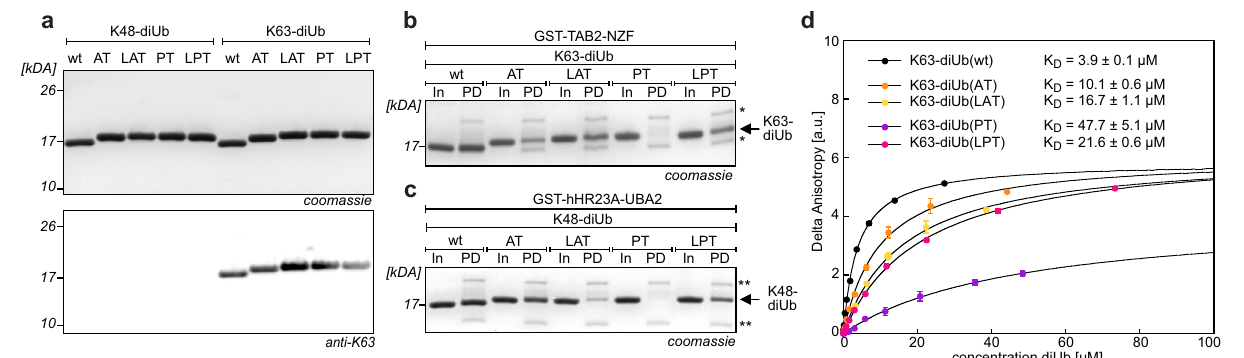
Fig. 2 Functional characterization of sortase-generated diUb building blocks used for Ubl-tools. a SDS-PAGE of K48- and K63-linked diUbs displaying different sortase motifs at their linkage sites (top: Coomassie-stained SDS-PAGE gels, bottom: western blot (WB) using an anti-K63-linkage-speci fi c antibody). b SDS-PAGE analysis of pull-down (PD) experiments using differently linked K63-diUbs and GST-fused TAB2-NZF. Single asterisk (*) marks impurities present in GST-TAB2-NZF. c SDS-PAGE analysis of PD experiments using differently linked K48-diUbs and GST-fused hHR23A-UBA2 (bottom). Double asterisks (**) marks impurities present in GST- hHR23A-UBA2. In: input of differently linked K48- or K63-diUbs, PD: pull-down. Full gels can be found in Supplementary Fig. 4. d Determination of binding constants of differently linked K63-diUbs towards fl uorescently labeled Rap80-tUIMs (79 – 124) using fl uorescence anisotropy. Delta anisotropy was plotted against diUb concentration and fi tted with a single-site binding model to determine K D values. Average values and error bars (s.d.) were calculated from three different experiments ( n = 3). All data processing was performed using Kaleidagraph software (Synergy Software, Reading, UK) or Prism 9.2.0 (GraphPad Software, LLC). Consistent results were obtained over at least three replicate experiments. Source data are provided as a Source Data fi